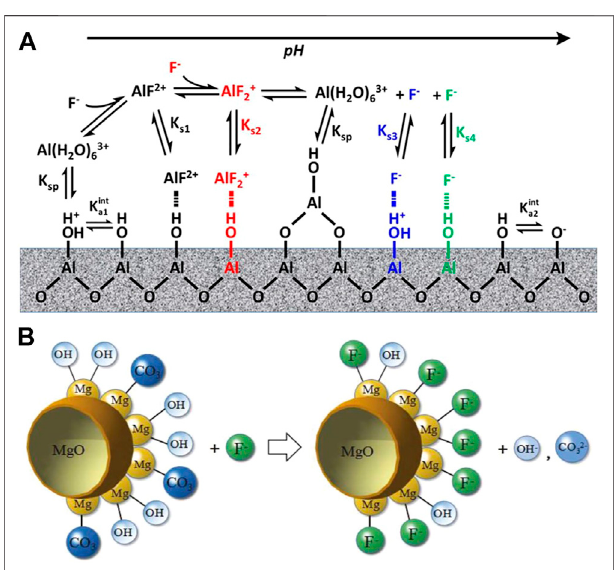
Frontiers in Chemistry |